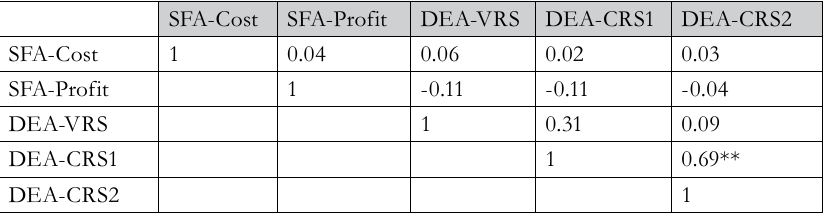
Tab. 7 – Spearman’s rank order correlation using different approaches. Source: author’s